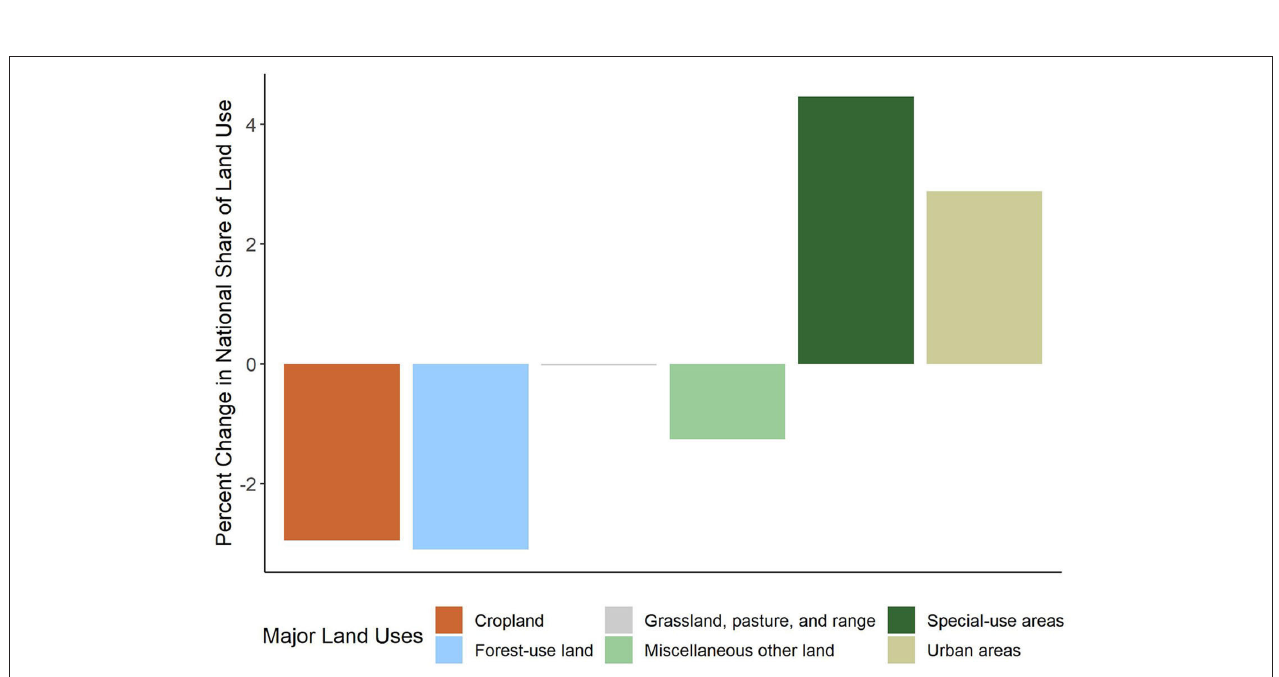
FIGURE 2 | Percent change in the national share of land use across the ERS Major Land Use categories between 1945 and 2012. Data: ERS